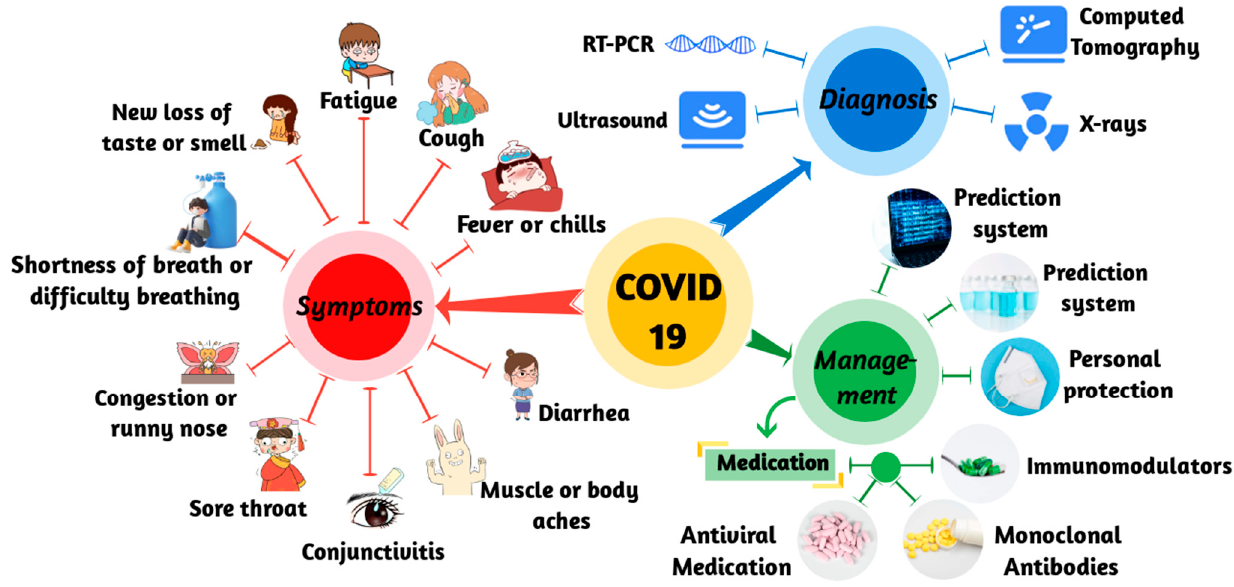
Figure 1. Schematic of COVID-19. It shows the symptoms, diagnosis, and management of COVID-19.